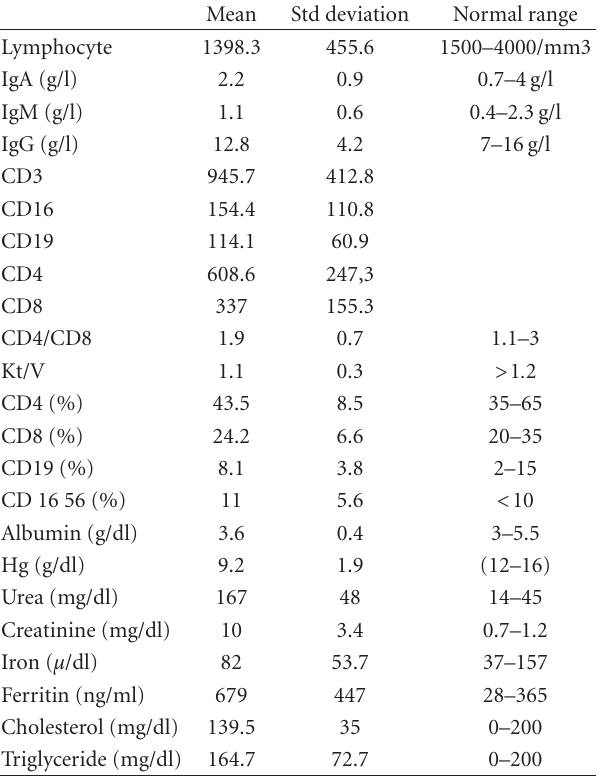
Table 1: Descriptive data for the study group for measured param-